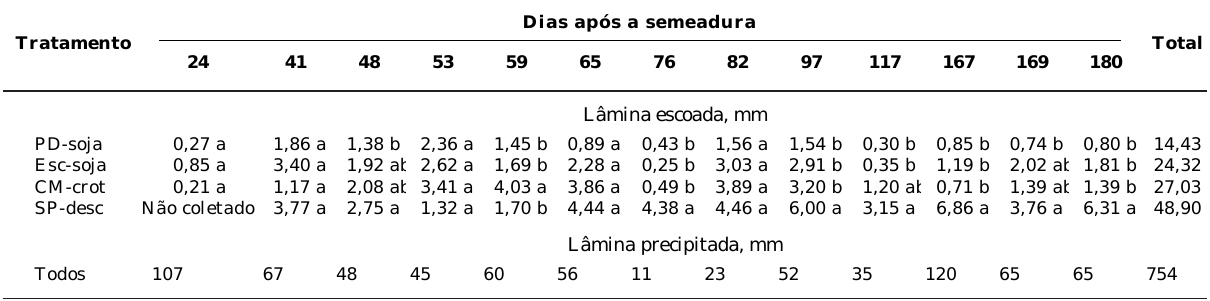
Quadro 3. Lâmina escoada sob chuva natural e precipitação pluvial em solo sob diferentes sistemas de manejo